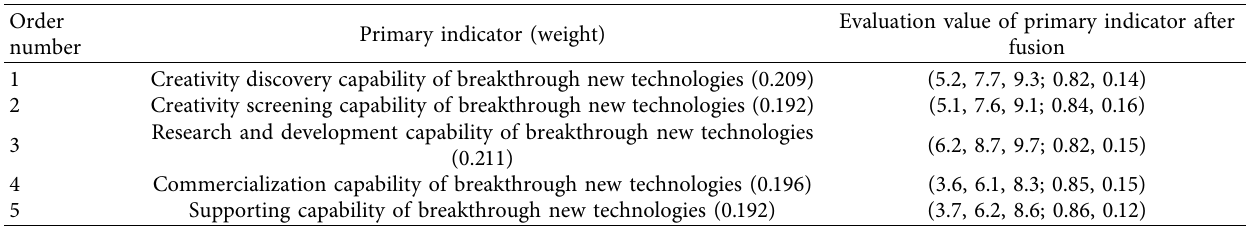
Table 5: Evaluating value of weighted fusion triangle intuitionistic fuzzy number of primary